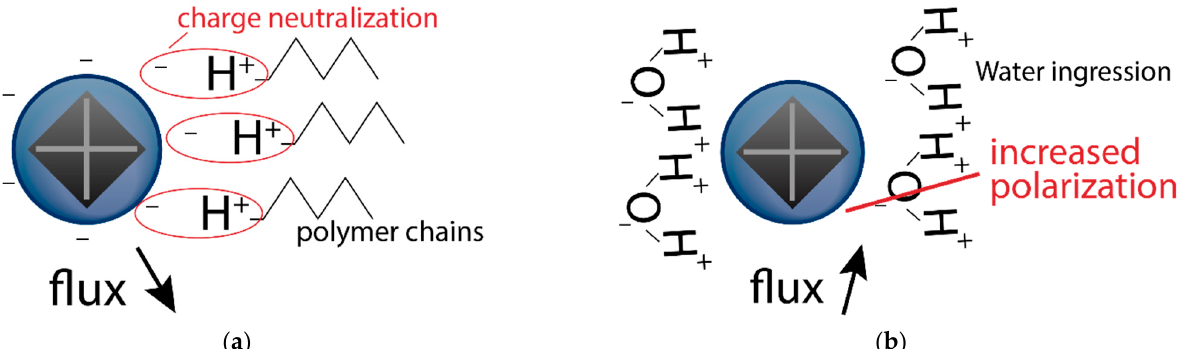
Figure 4. ( a ) Charge neutralization of individual MENs as a function of polymer coating; ( b ) polar- ization of MENs as a function of water ingression. ization of MENs as a function of water ingression.